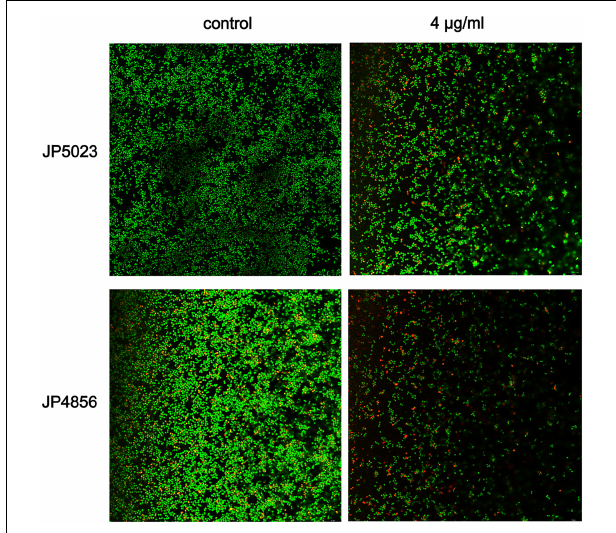
FIGURE 6 | Biofilm formation was observed by CLSM. JP5023 and JP4856 treated with SYG-180-2-2 (4 µ g/ml).